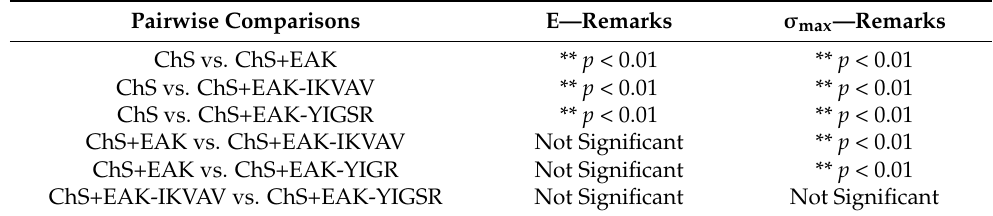
Table 2. Statistical analysis on mechanical properties of ChS, ChS+EAK, ChS+EAK-IKVAV,